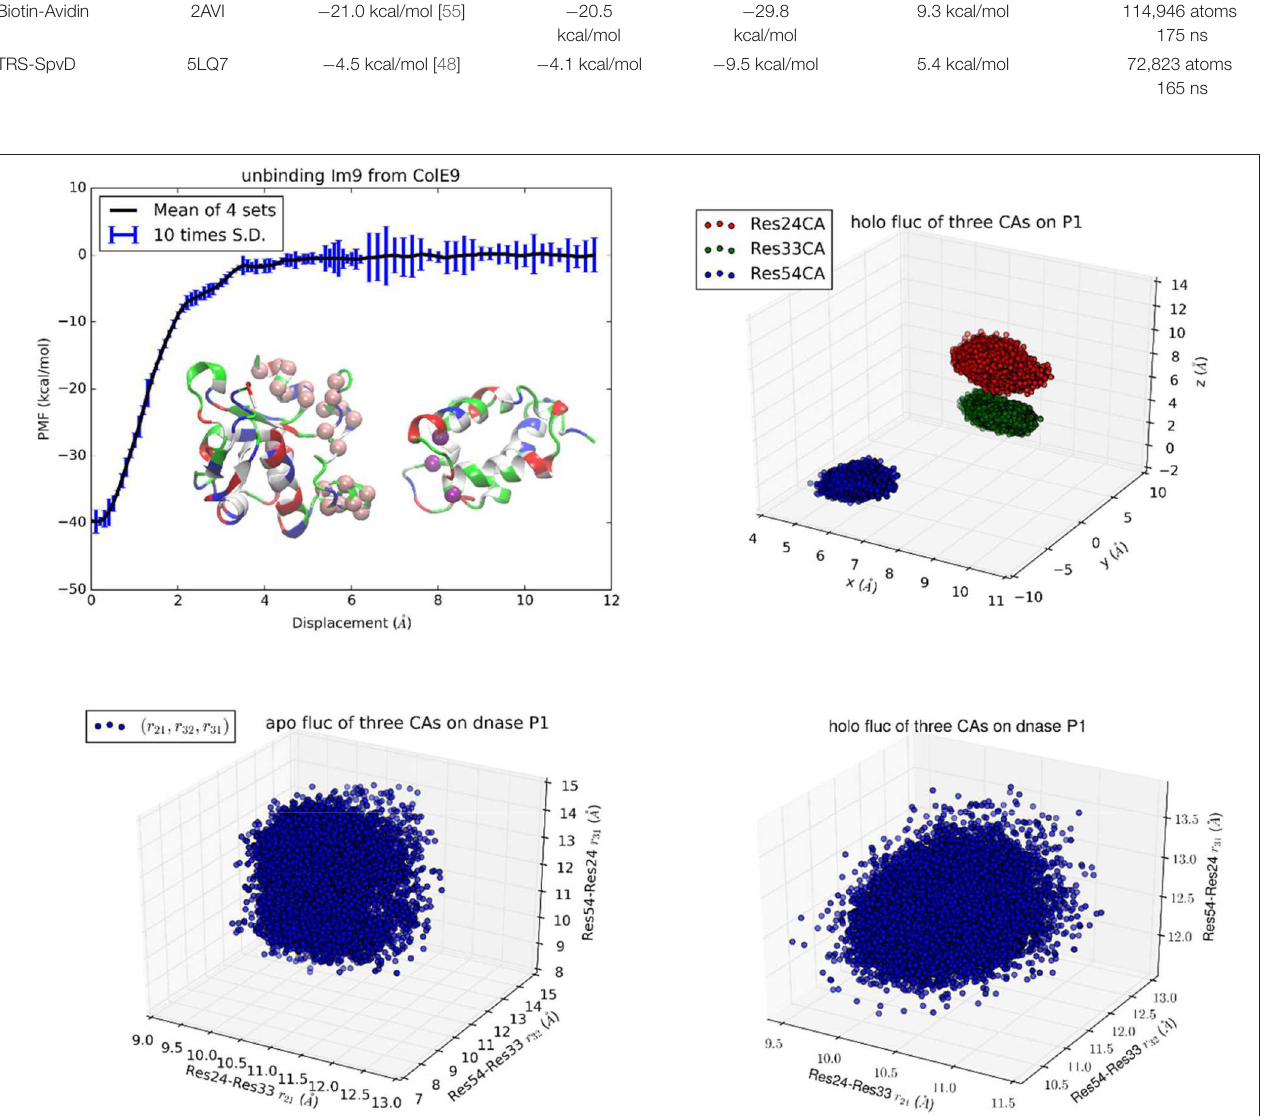
FIGURE 1 | Unbinding Im9 immunity protein from Colicin E9 DNase with Protocol 1. Shown in the upper left panel is the PMF curve of unbinding Im9 from E9. Insets: Im9 and E9 in the unbound state are shown in ribbons colored by residue types (hydrophobic, white; hydrophilic, green; negatively charged, red; positively charged, blue). The three centers ( α -carbons) on Im9 (Asn24C α , Leu33C α , and Tyr54C α ) are marked as purple balls, whose coordinates represent the position and orientation of Im9. The 22 centers ( α -carbons) on E9 DNase (Pro73C α , Ser74C α , Asn75C α , Lys76C α , Ser77C α , Ser78C α , Val79C α , Ser80C α , Phe86C α , Lys89C α , Asn90C α , Gln91C α , Val93C α , Arg96C α , Val98C α , Pro124C α , Lys125C α , Arg126C α , His127C α , Ile128C α , Asp129C α , and Ile130C α ) are marked as pink spheres whose fluctuations in the bound and the unbound states are computed for shifting and rigidifying (or softening) of the interface residues upon binding. The upper right panel shows the fluctuations of the three centers in the bound state in terms of their coordinates: ( x 1, y 1 , z 1 ), ( x 2, y 2 , z 2 ), and ( x 3, y 3 , z 3 ). The lower left/right panel shows their fluctuations in the unbound/bound state in terms of three mutual distances: ( r 21 , r 32 , r 31 ).